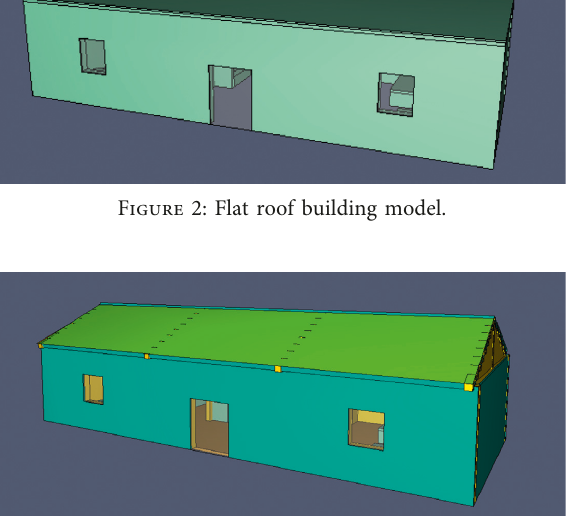
Figure 3: Sloping roof building model. Table 1: Fire